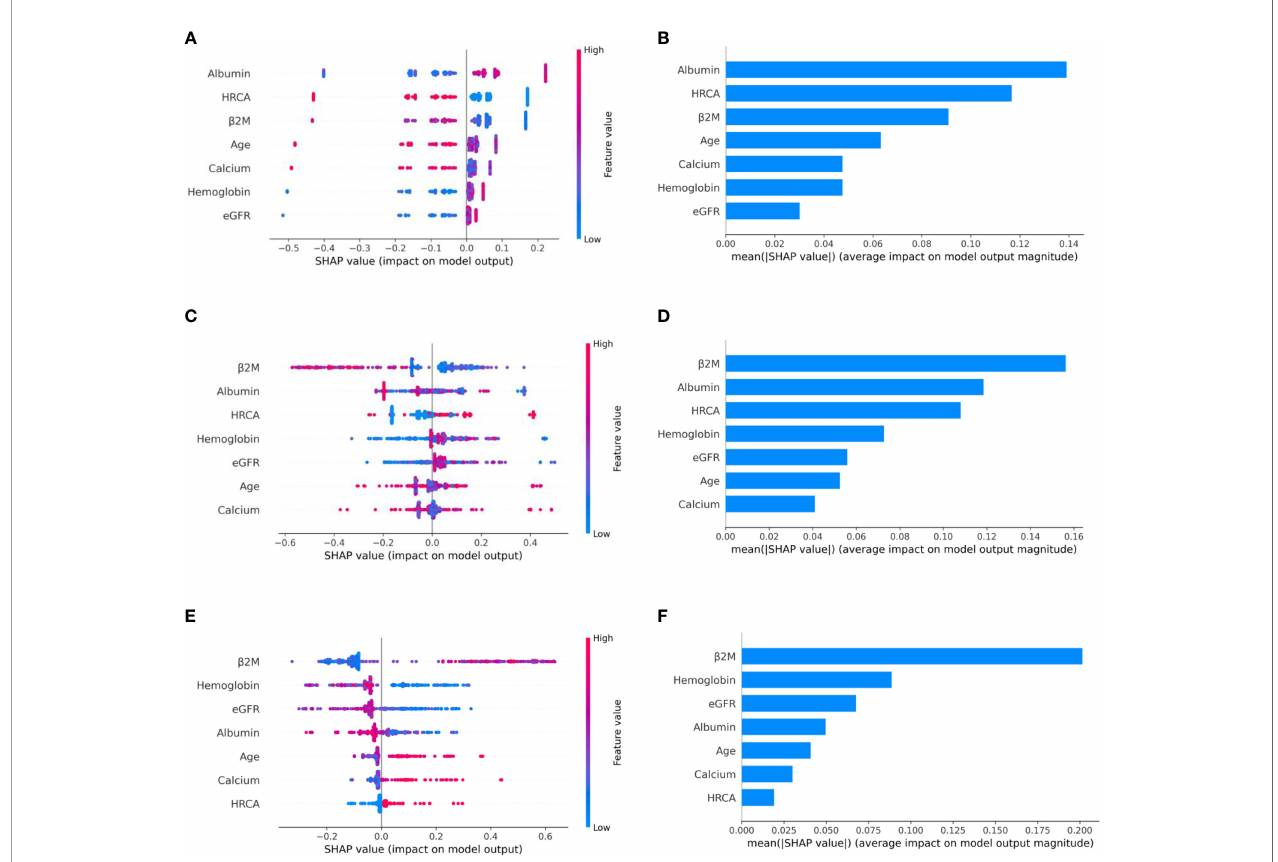
FIGURE 7 | Model interpretation using SHAP. SHAP summary plots for different risk stages inferred in MMRF data showing the impact of different parameters used in the model. (A, B) CRSS-1: albumin, HRCA, and b 2M have the highest impact on the low-risk stage. Normal levels of albumin, absence of HRCA, and lower values of b 2M are contributing to low risk (CRSS-1) in myeloma patients. (C, D) CRSS-2: b 2M, albumin, and HRCA are the key contributors to the intermediate-risk stage. (E, F) CRSS-3: b 2M and hemoglobin have the highest impact on the high-risk stage. Elevated levels of b 2M and lower values of hemoglobin are contributing toward the high-risk stage in the patient. Lower values of albumin and eGFR are further promoting high-risk stage